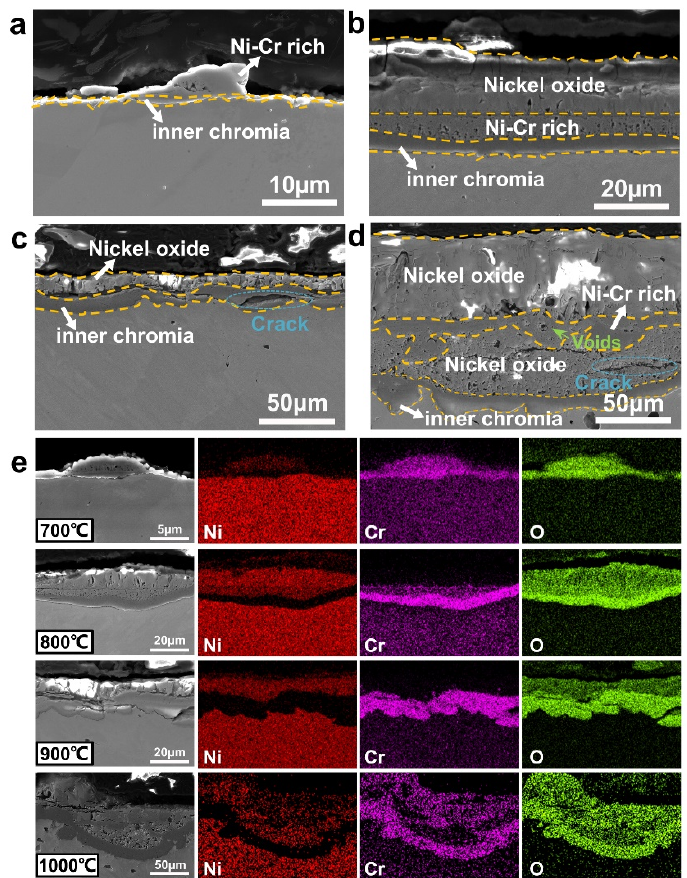
Figure 4. Cross-sectional microstructures (SE images) of oxide scales formed on Ni-20Cr alloy oxidized at ( a ) 700 °C, ( b ) 800 °C, ( c ) 900 °C, and ( d ) 1000 °C for 576 h. Note that the integrity of the chromia layer is destroyed with rising temperatures, which leads to the degradation of oxidation resistance. ( e ) EDS maps of oxide scales formed on Ni-20Cr alloy at temperatures ranging from 700 °C to 1000 °C.